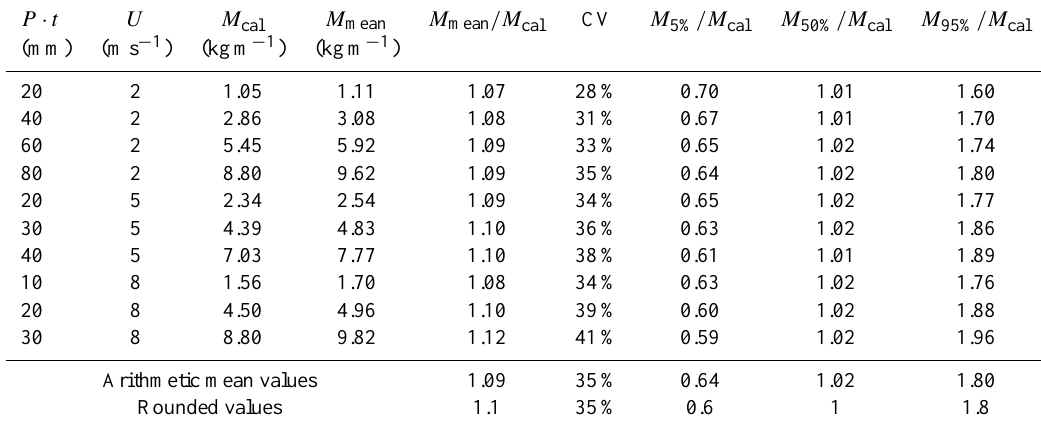
Table 1. Main results of the 200000 random trials composed of 10 different fixed couples ( P · t , U ) associated with 20000 random sets of parameters ( V t , ρ s , n , CR). P ·